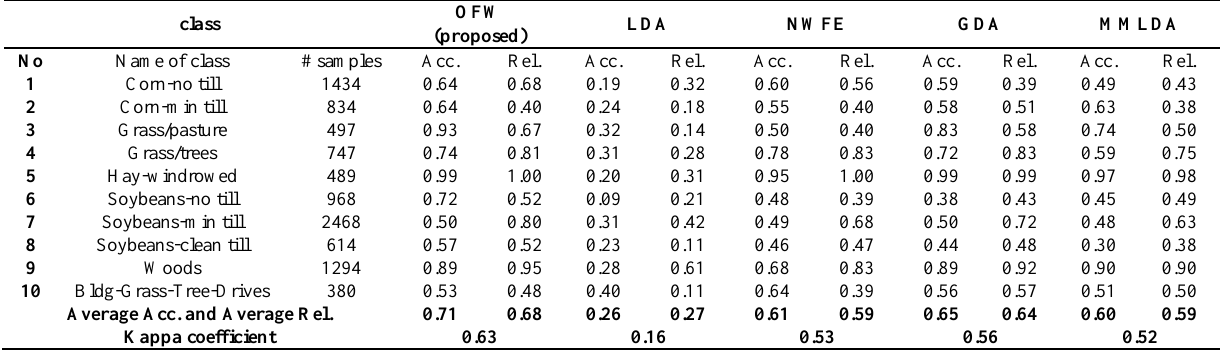
Table 1. Accuracy and reliability of classes of Indian dataset obtained by SVM classifier and 9 extracted features.